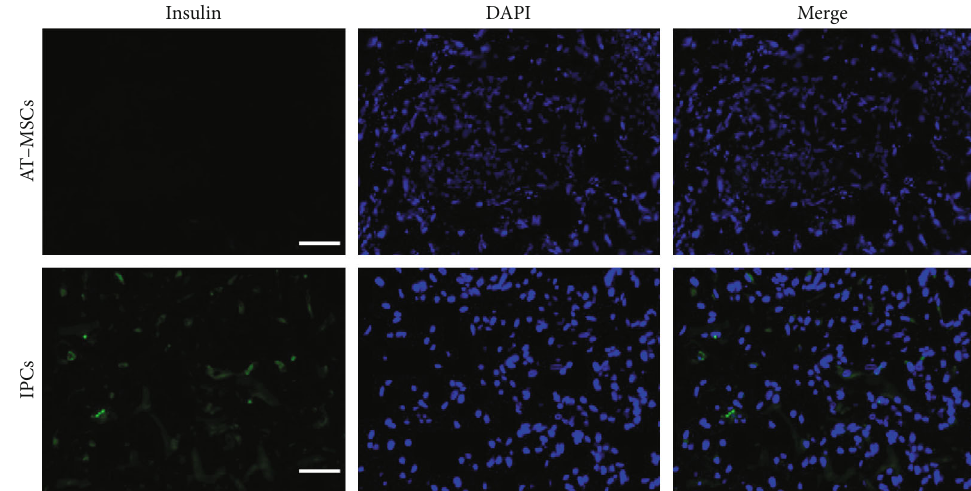
Figure 4: Immuno fl uorescence of canine adipose-derived mesenchymal stem cells (AT-MSCs) following in vitro di ff erentiation into insulin- producing cells (IPCs). Cells were stained for insulin (green) with counterstaining for DAPI (blue). Bar = 50 μ m